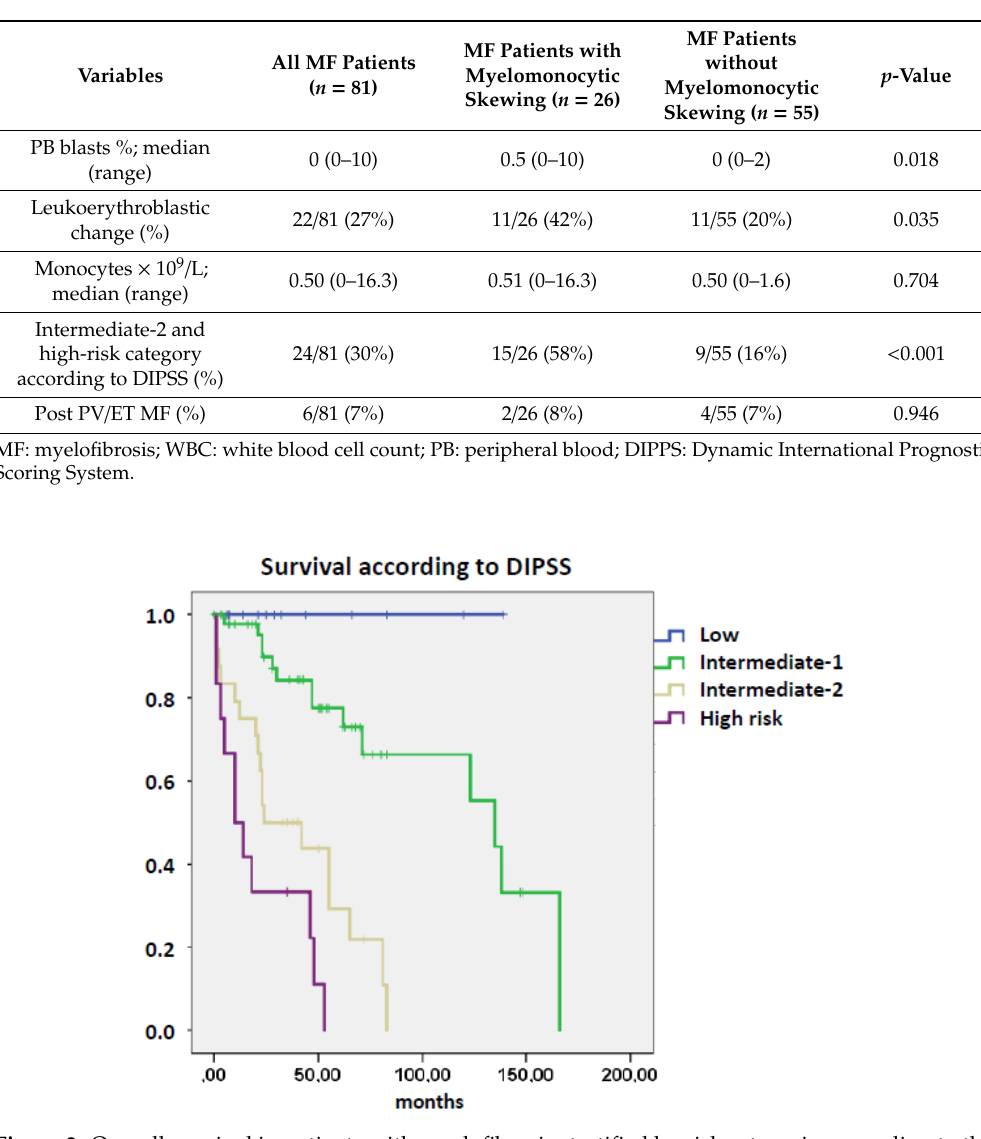
Figure 3. Overall survival in patients with myelofibrosis stratified by risk categories according to the Dynamic International Prognostic Scoring System (DIPSS) score.